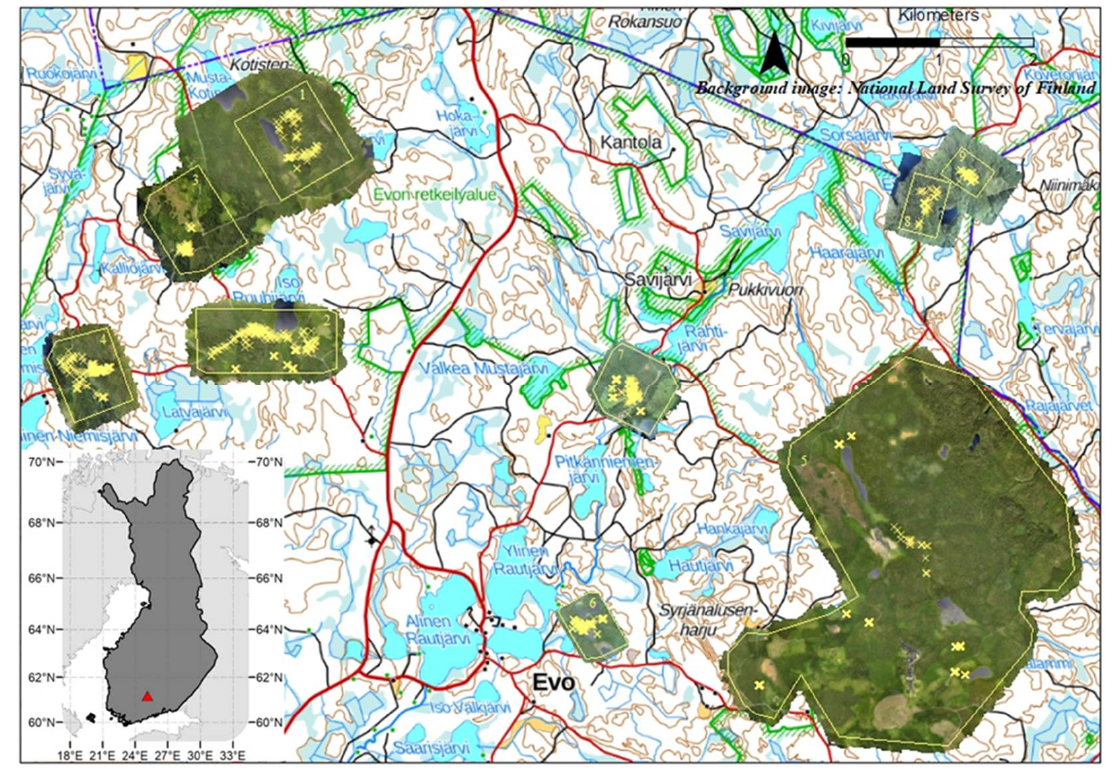
Figure 2. Location of the study area, UAV data and field data.